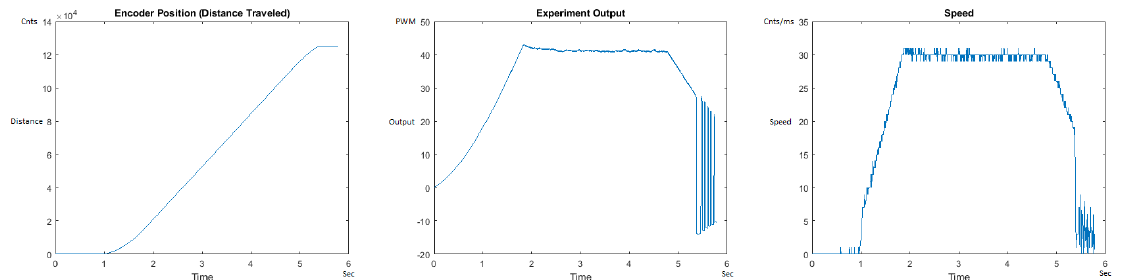
Figure 13. Encoder position, output and speed plots for PID++ UP operation— Vmax 30 cnts/ms, Adesired 0.055 cnts/ms 2 — 10